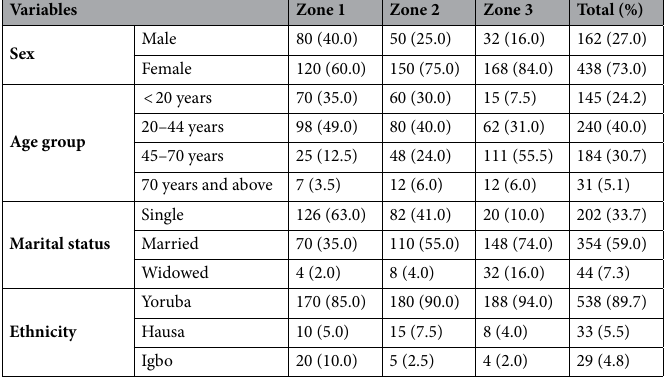
Table 1. Socio-demographic profile of respondents. Bracketed figures represent the percentages of each figure (frequencies) beside them.